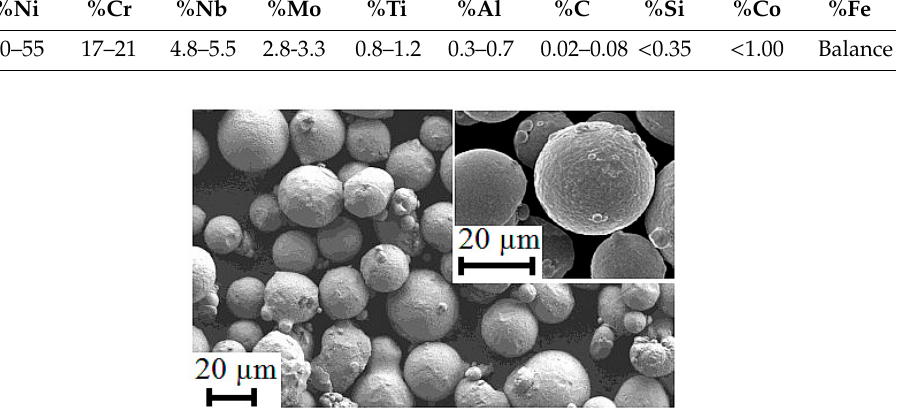
Figure 1. SEM images of the morphology of the Inconel 718 powder.